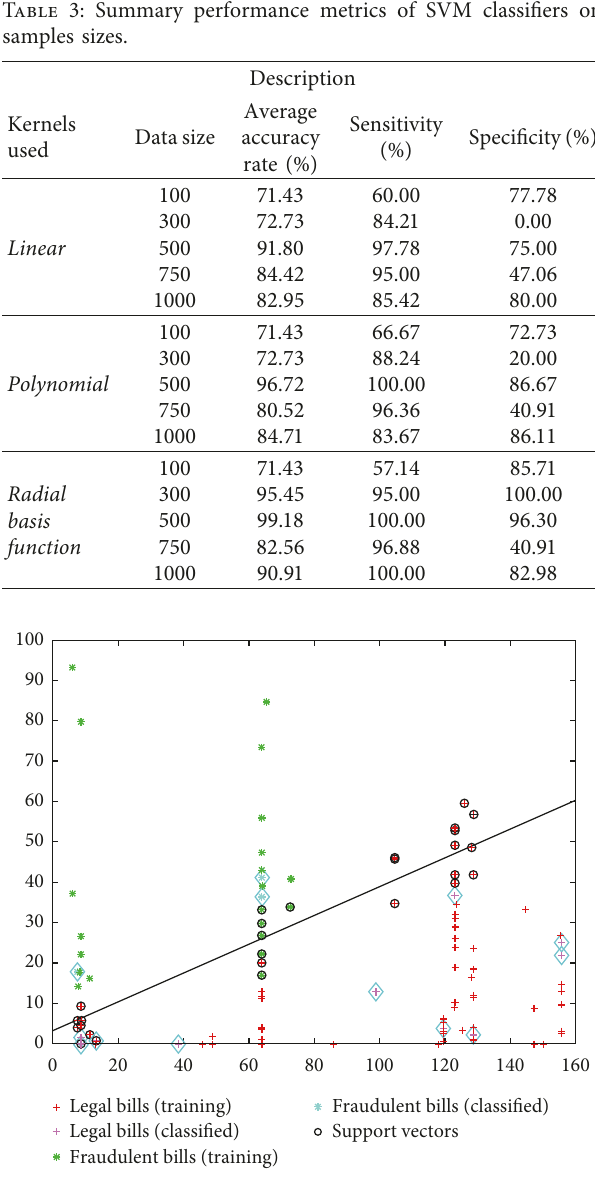
Table 3: Summary performance metrics of SVM classifiers on samples sizes.